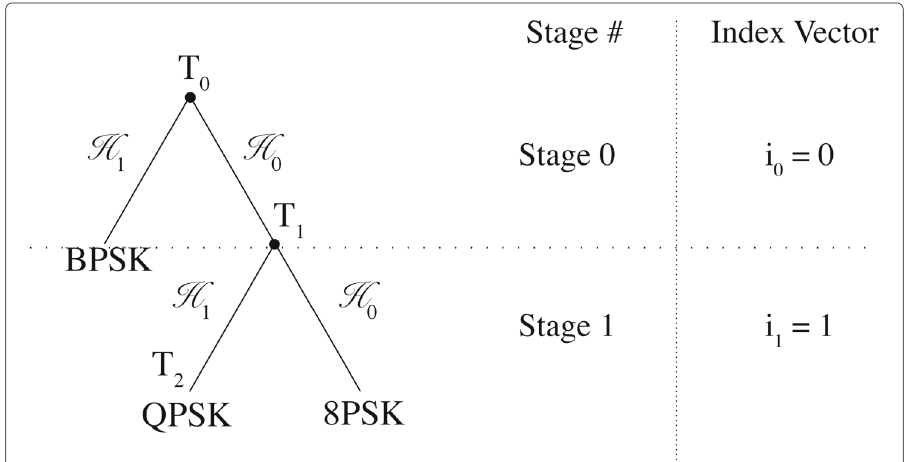
Fig. 8 Decision Tree of Ex.